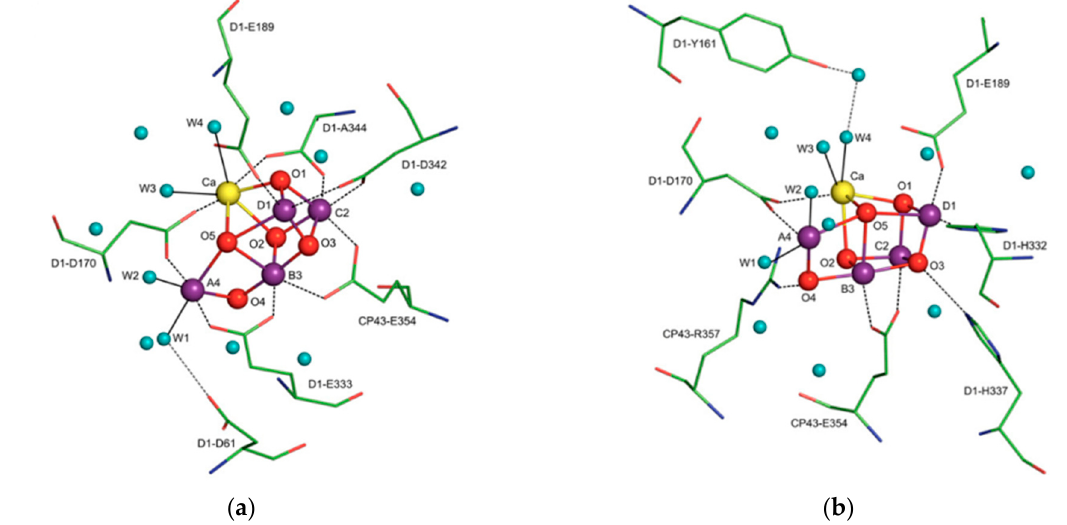
Figure 4. The X-ray crystal structure of the water-oxidizing complex of photosystem II. For clarity of presentation only selected amino acids are shown in views ( a , b ). Blue spheres, water molecules; magenta spheres, manganese ions; red spheres, μ -oxo bridges; yellow sphere, calcium. Reprinted from Biochimica et biophysica acta, 1827, Cox, N.; Messinger, J. Reflections on substrate water and dioxygen formation. 1020–1030, Copyright (2013), with permission from Elsevier.